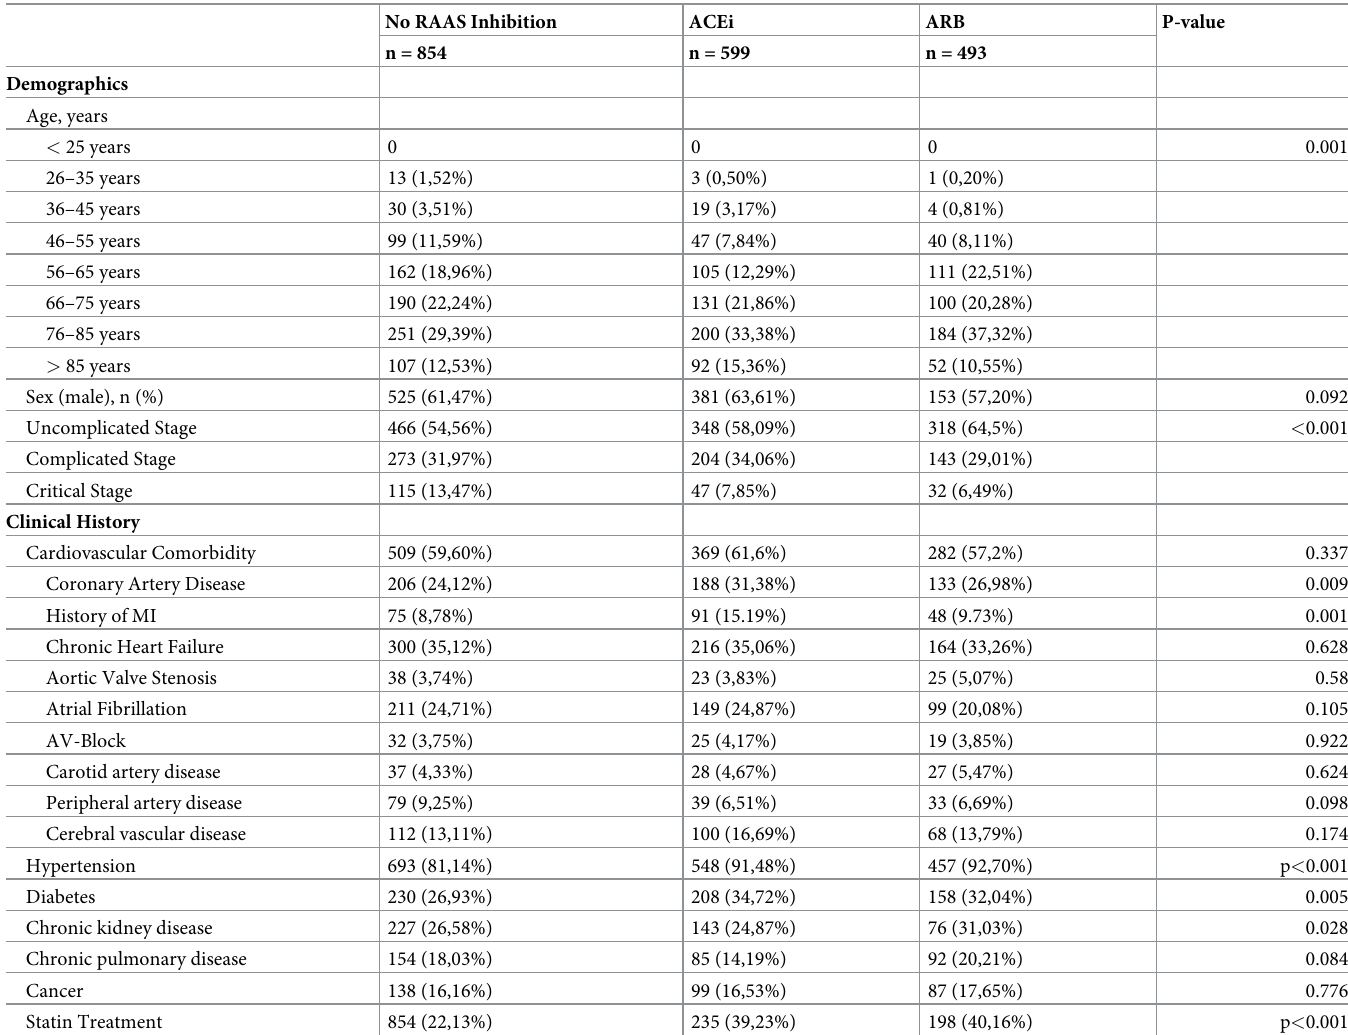
Table 1. Baseline characteristics of patients included in the